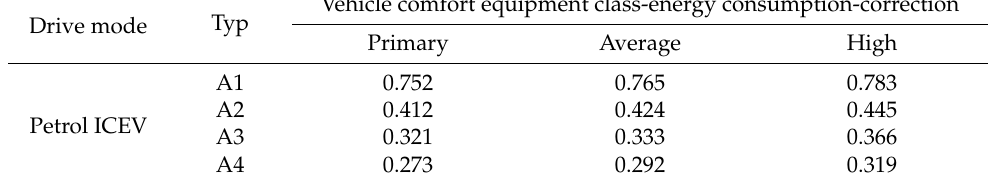
Table 5. Total cost of ownership of the reference vehicle with ICEV gasoline engine for 3 equipment classes depending on the types of users with the introduction of the sub-model related to aperiodic failures and other unforeseen circumstances of use